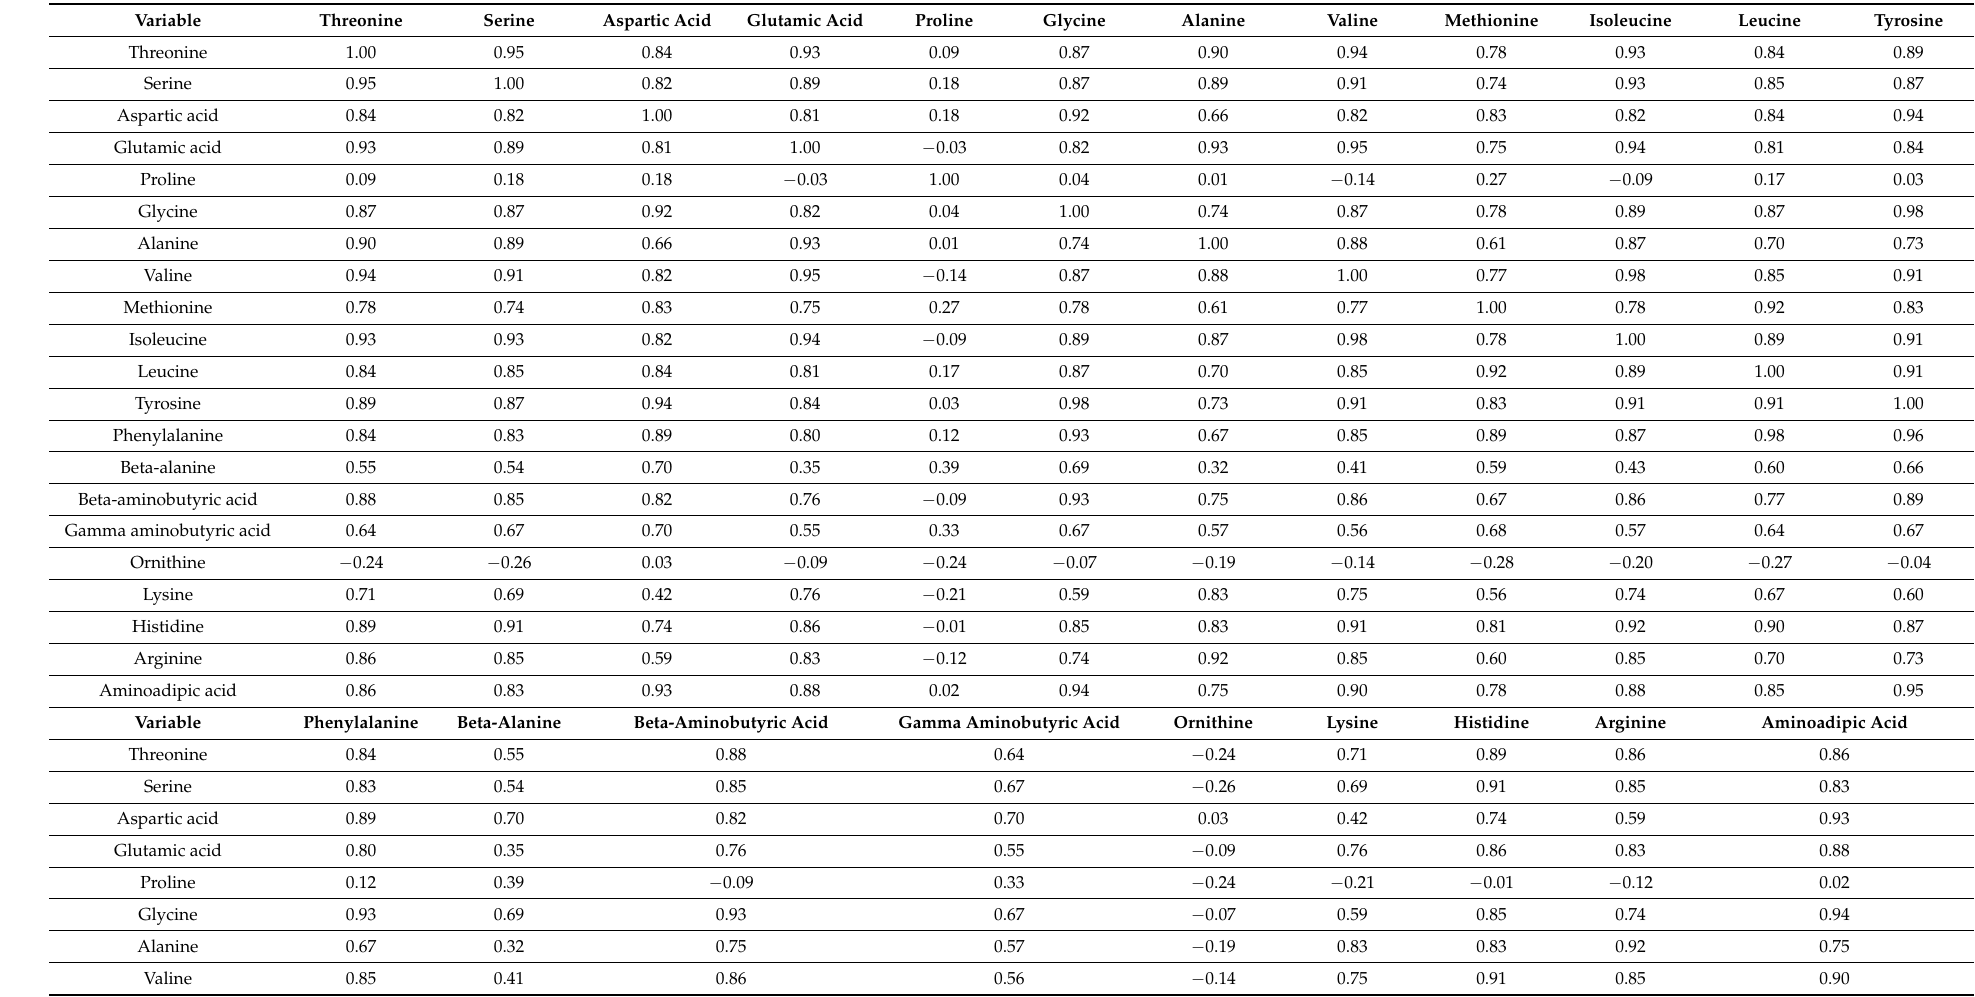
Table 3. Correlation matrices of the individual amino-acid dependencies among